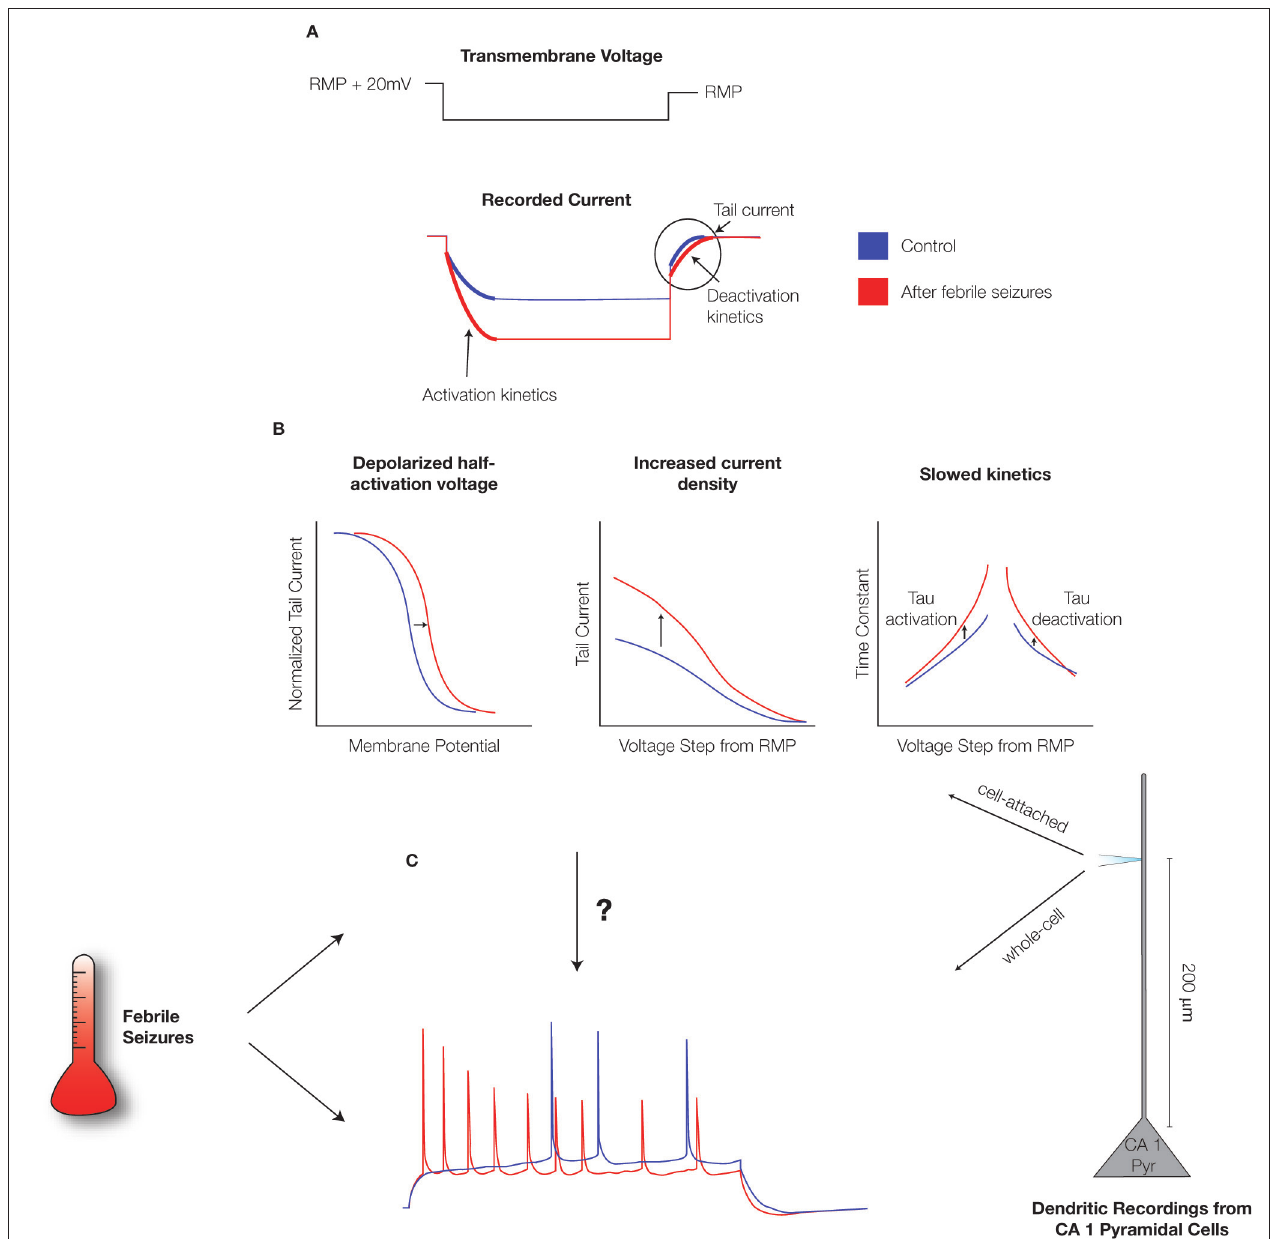
result in altered properties of I in the dendrites of CA1 pyramidal neurons: Figure 1 | Febrile seizures alter I in CA1 pyramidal neurons. ( A ) Schematic h h a depolarized half-activation potential, slower time-constants of activation of the cell-attached, dendritic recordings of I from CA1 pyramidal cells from h and de-activation, and ∼ 70% increased current density ( Dyhrfjeld-Johnsen control animals and from animals that were exposed to hyperthermia-induced, et al., 2008 ). ( C ) Whole-cell dendritic current injection experiments in the experimental prolonged febrile (fever-induced) seizures. The dendritic patch current-clamp mode showed that CA1 pyramidal dendrites are hyperexcitable was held in voltage-clamp mode, a voltage command was applied, and the following febrile seizures. However (as illustrated by the arrow with the resulting currents were recorded. The activation and de-activation kinetics, question mark), this raised the question of how the changes in I parameters along with the maximal currents, were derived from the recordings as h relate to the observed increases in indicated. ( B ) Analysis of current recordings showed that febrile seizures